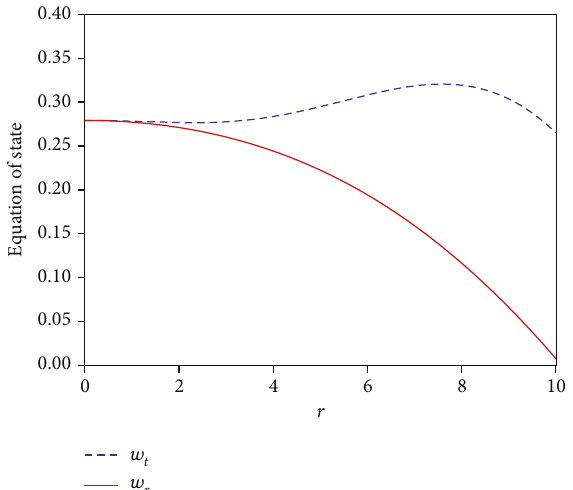
Figure 10: Equation of state against radial distance r .